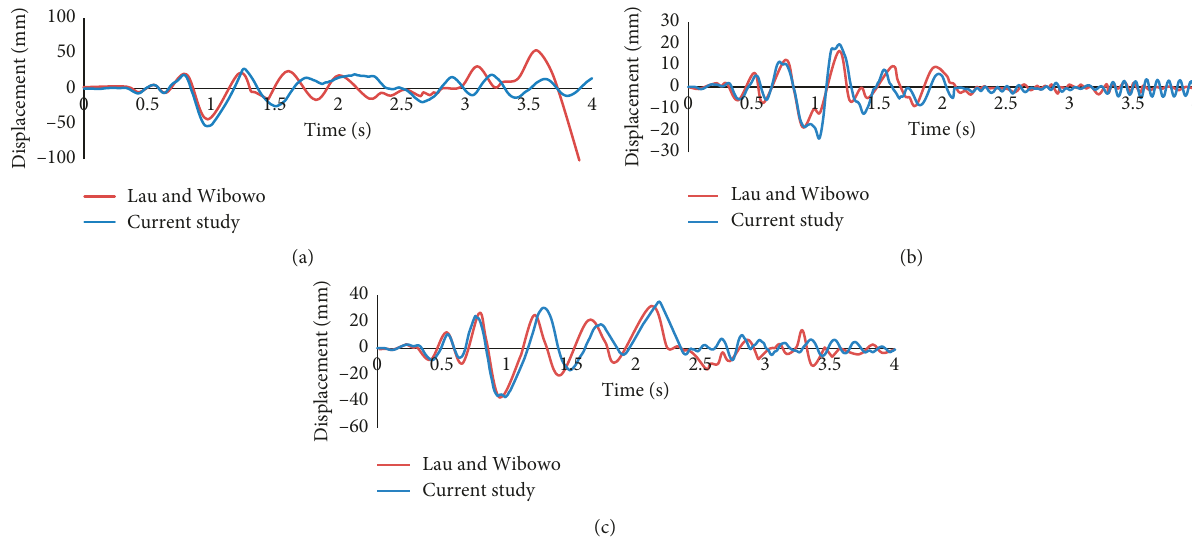
Figure 10: Comparison of the displacement response of bridge b213 piers with nonlinear deck using AEM in the current study, and Lau and Wibowo [3] research: (a) short, (b) medium, and (c) tall pier. Table 2: Comparison between box girder and voided slab decks’ cross sectional properties. Box girder (Prestressed) voided